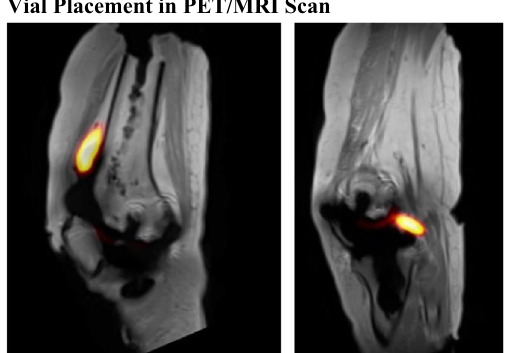
Fig. 1 Sagittal views of fused PET/MRI scans of the cadaver knee demonstrating vial placement in the anterior (left) and mid (right)